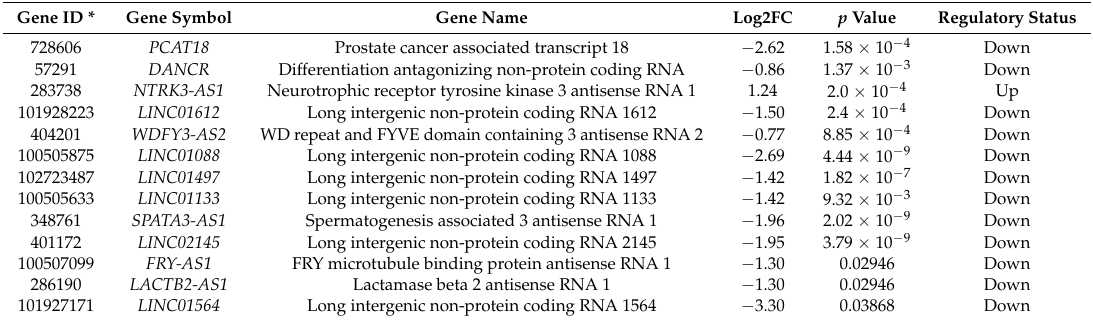
Table 1. Differentially expressed lncRNAs in gastric cancer based on analyses of the four discovery GEO datasets.